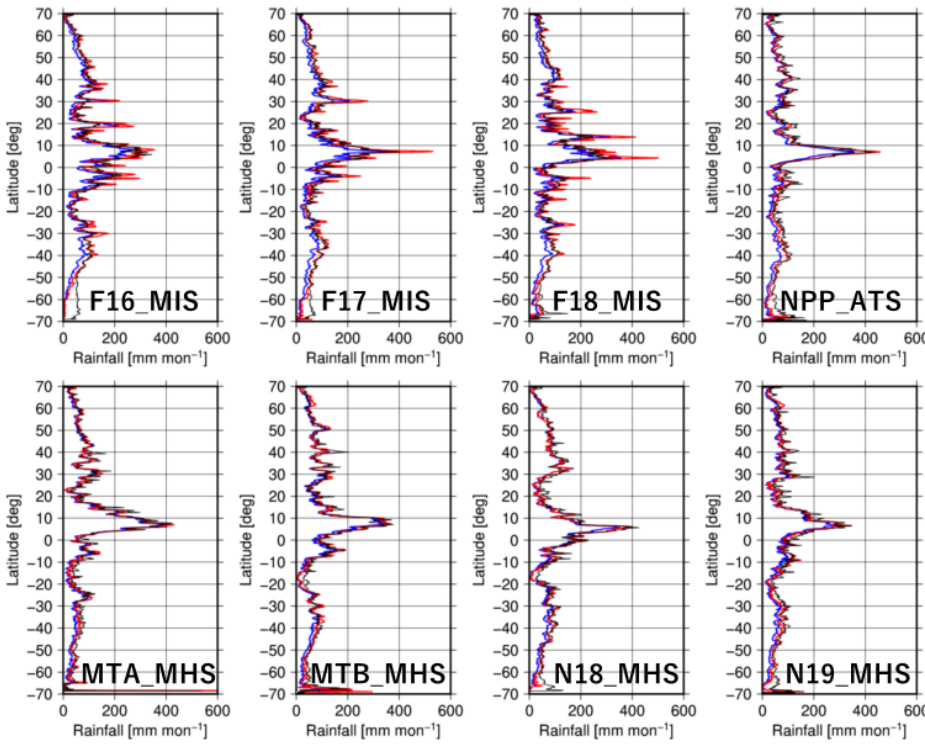
Figure 4. Zonal mean rainfall amount of matchup between target PMW sensors (named in each figure) and COR_GMI (black line) before (blue line) and after (red line) the MMN correction over the